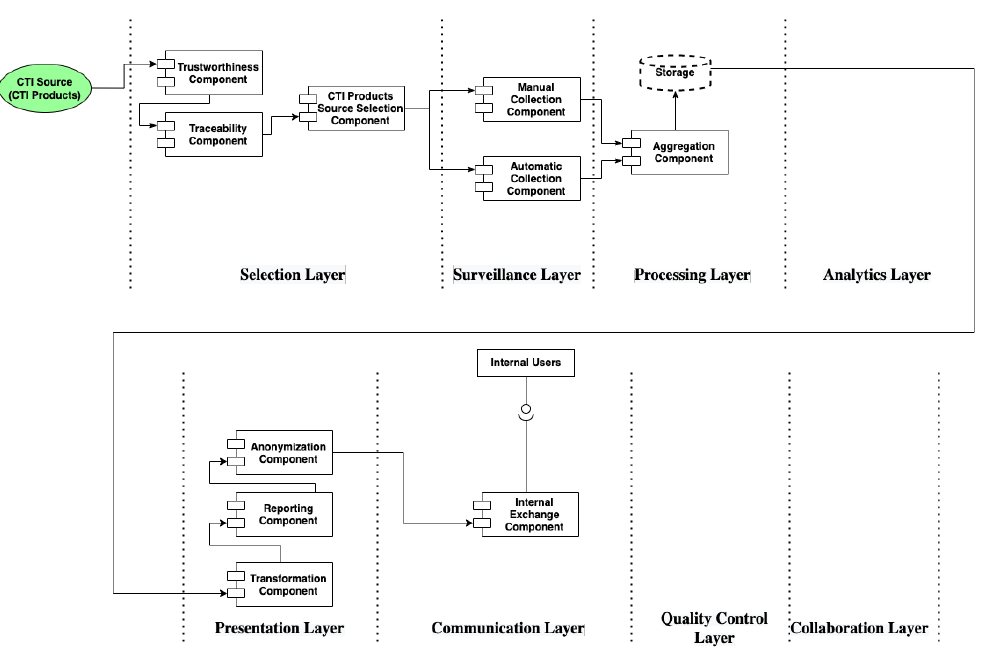
Figure 13. CTI Reference Architecture of Case Study